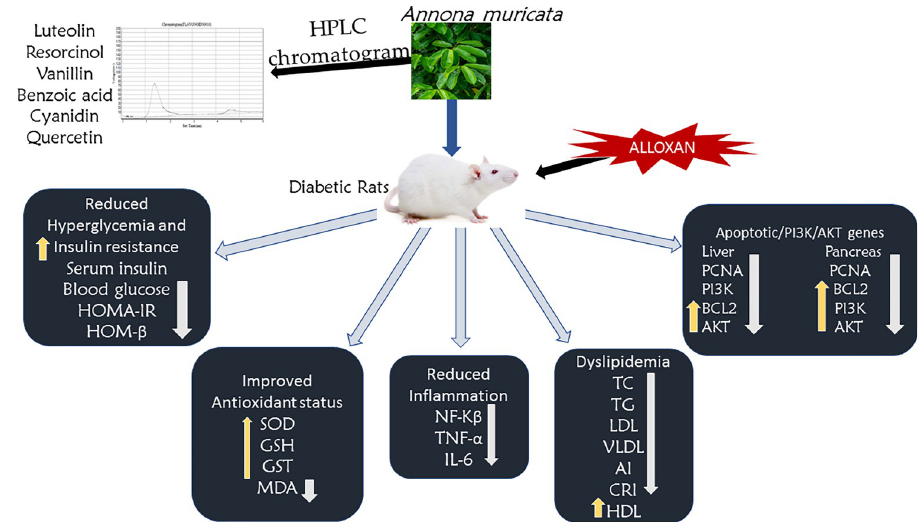
Fig 6. Schematic illustration of key findings of the present study. The proposed mechanism of action of A . muricata peels in diabetic rats on improving insulin binding and increase glucose metabolism. A . muricata , upregulates mRNA expression of the pancreatic PI3K, Akt, and Bcl2 genes and liver Akt, and Bcl2 genes while liver PI3K, PCNA, and pancreas PCNA were not downregulated by alloxan. This leads to increase in the insulin sensitivity and reduce the blood